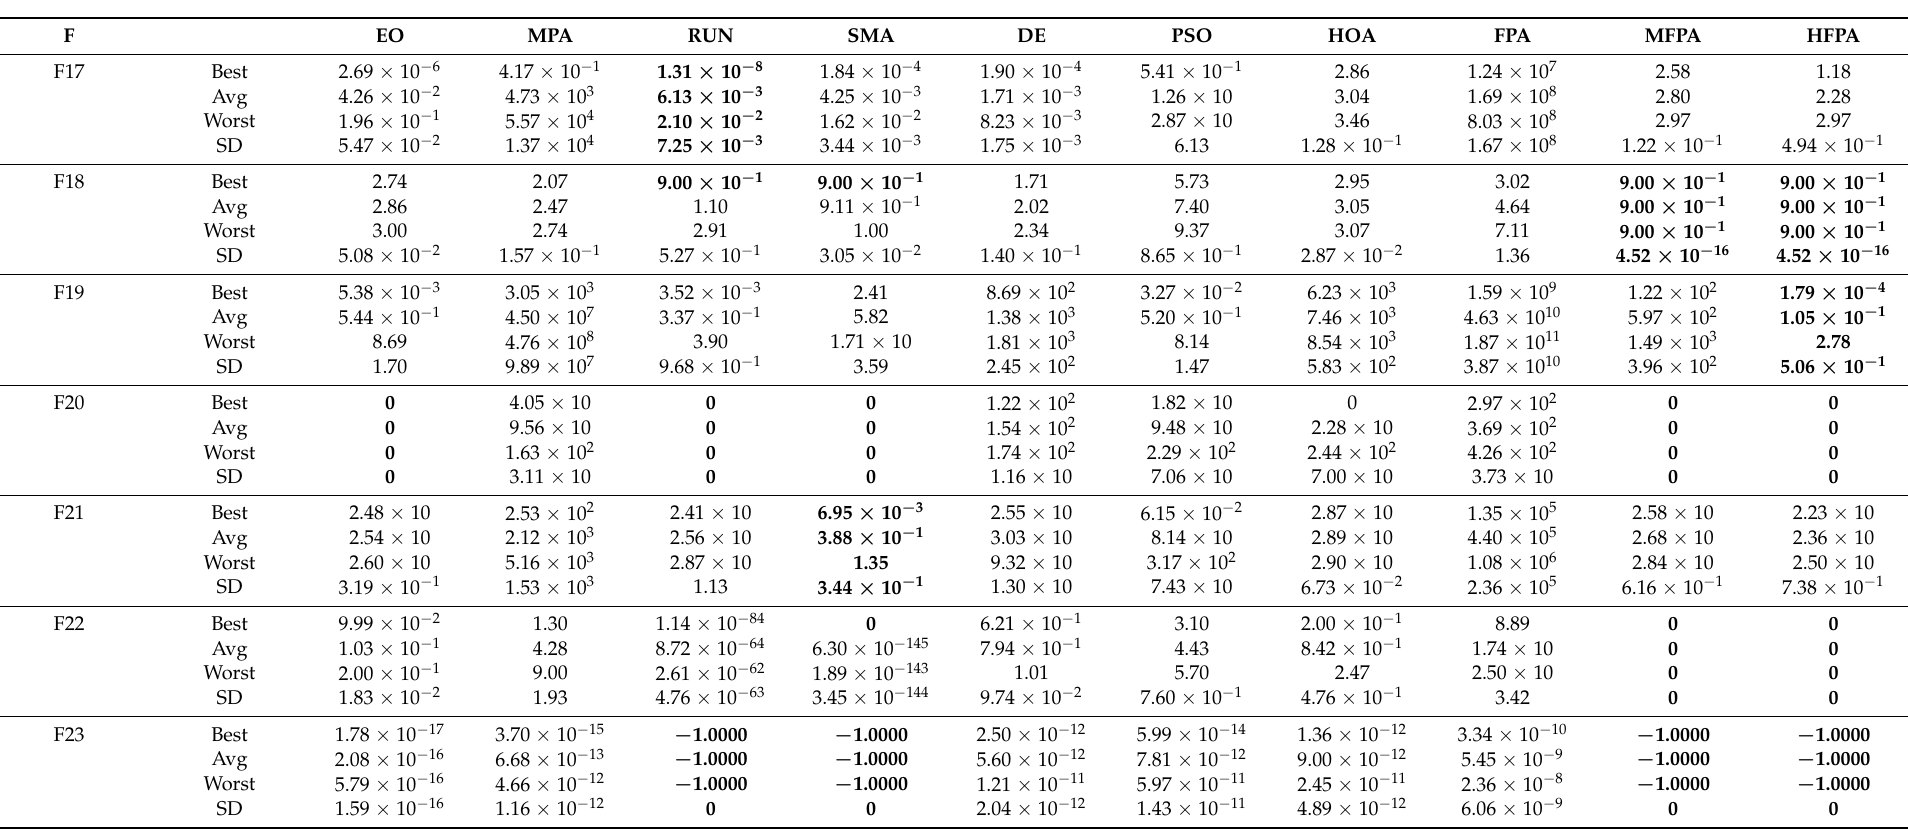
Bold values indicate the best